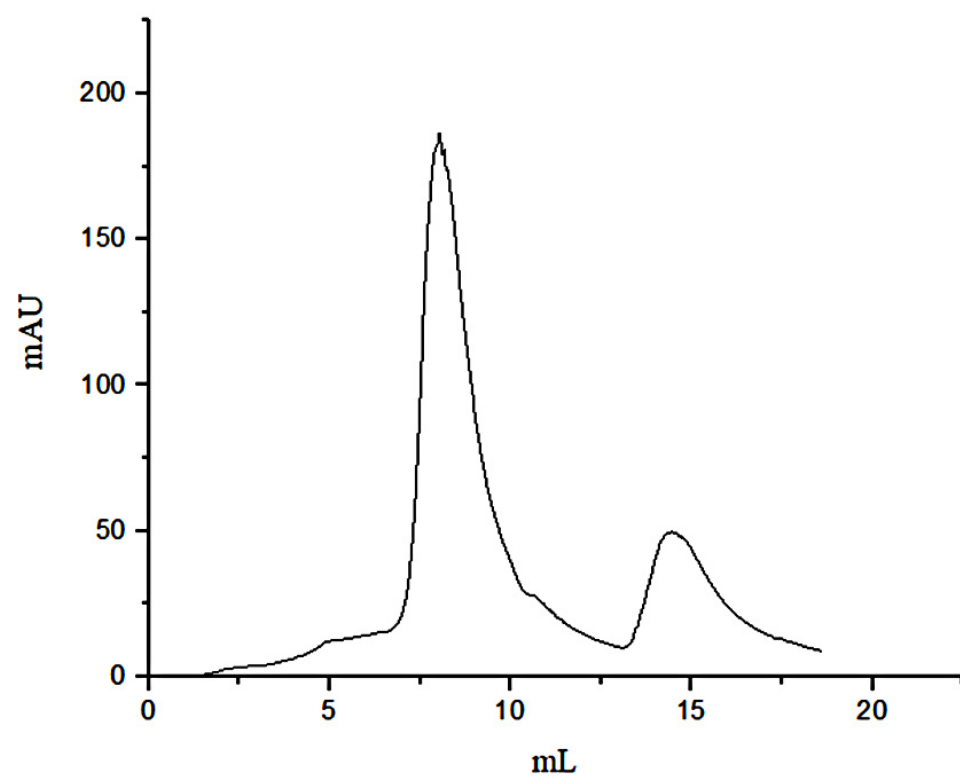
Figure 1. Affinity chromatography of separation peptides in the gelatin.